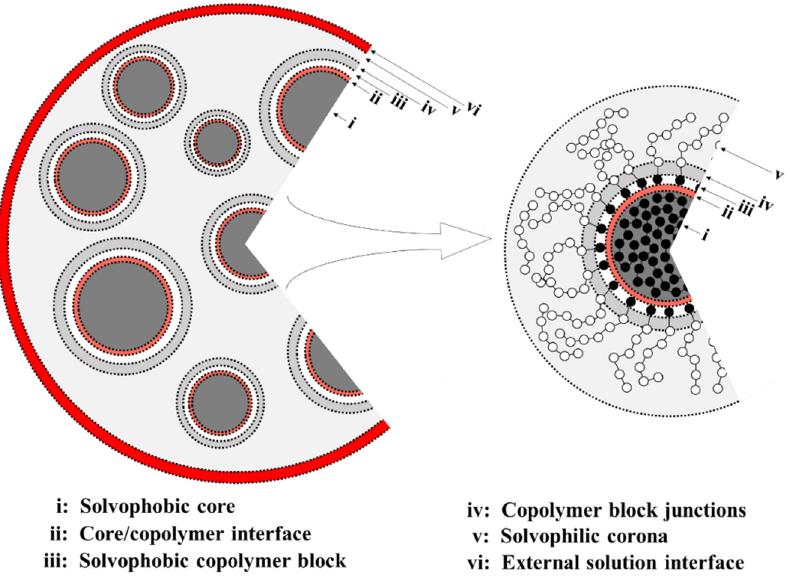
Figure 7. Schematic of the multicore aggregate assembled from small micelles (left panel) and the structure of one of them (right panel). In the small micelle, the black and white spheres represent solvophobic and solvophilic beads, respectively.